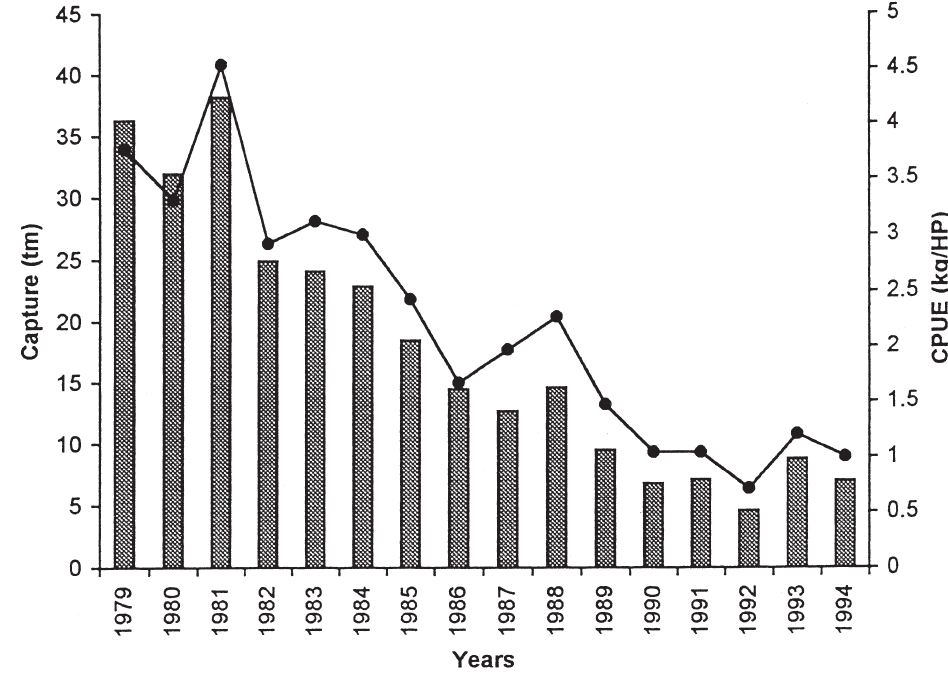
F IG . 3. – Plot of landings at Barcelona harbour and CPUE from Serola bank between 1979 and 1994. Bars, captures (in tm). Line, CPUE (in kg HP -1 year -1